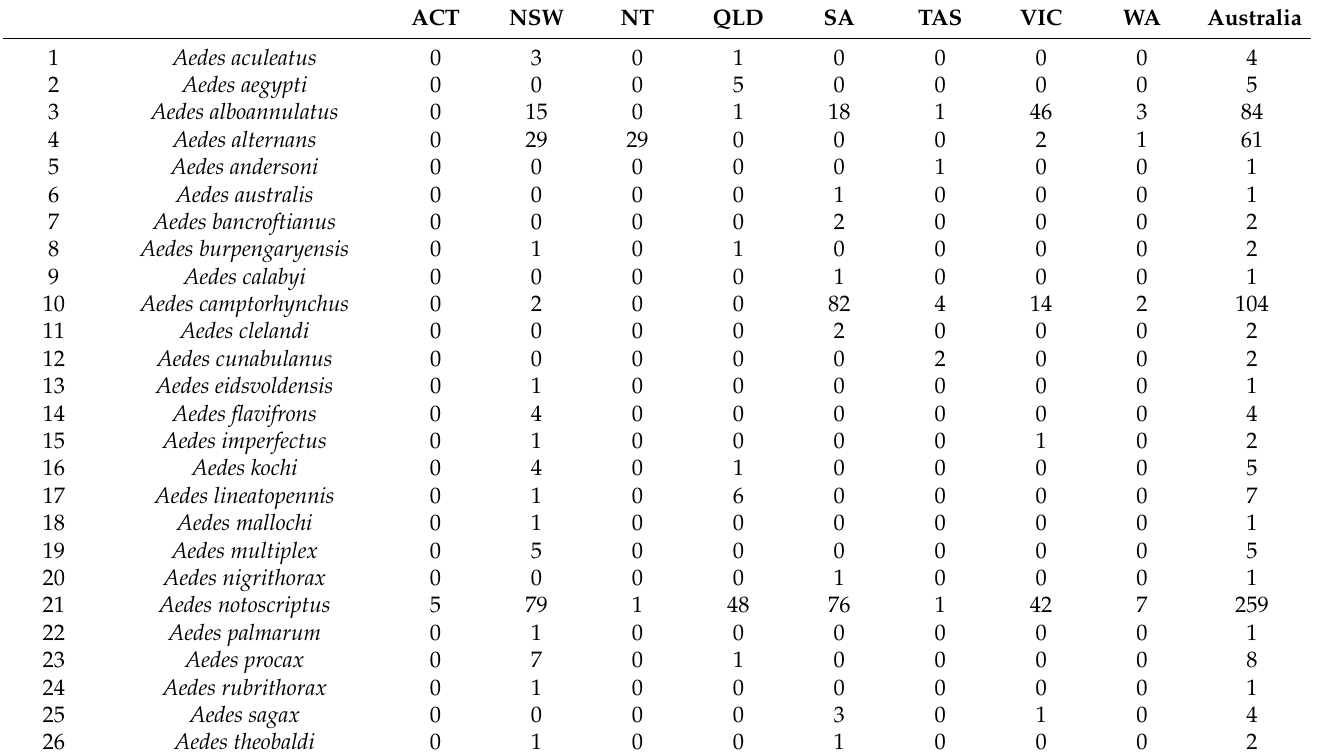
Table 3. Species richness and number of observations on the Mozzie Monitors project on iNaturalist per state in Australia, from 2000 to